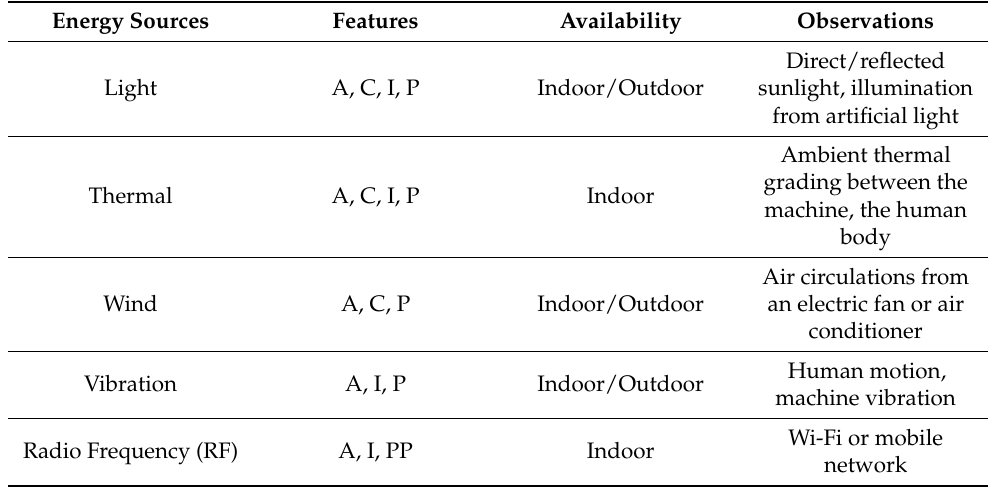
Table 2. Characteristics of indoor energy sources.